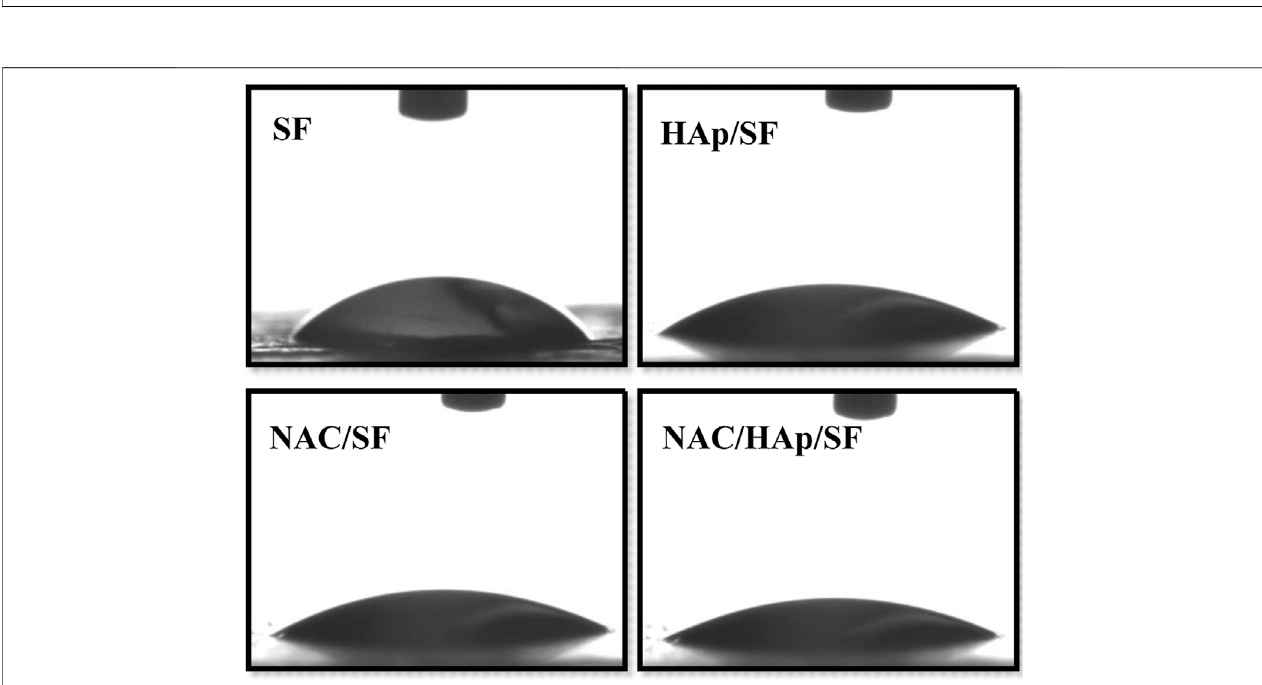
FIGURE 3 | Hydrophilic properties of the SF, HAp/SF, NAC/SF, and NAC/HAp/SF composite fi ber membranes, n (cid:1) 3.